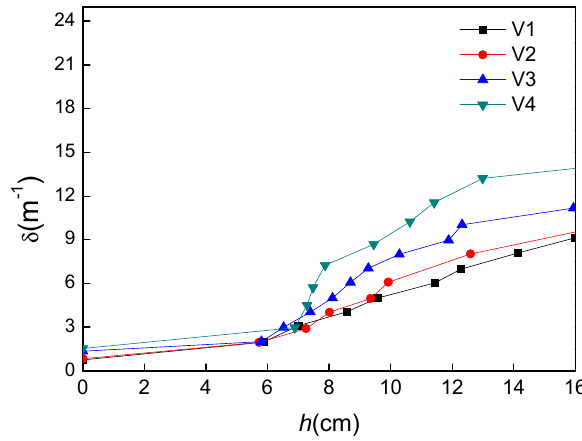
Figure 4. Profiles of vegetation densities against water depth in different vegetation distribution patterns, where h is the water depth and δ is the vegetation density.